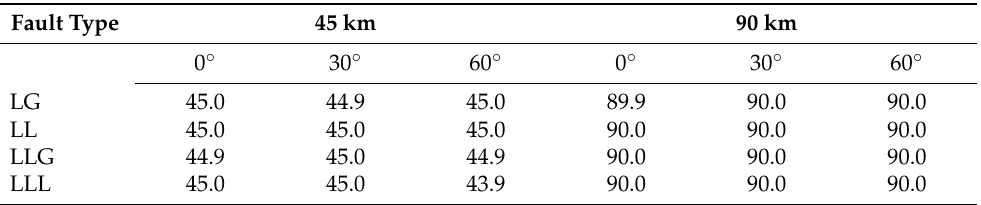
Table 10. Fault estimation at 45 and 90 km with a 10 Ω fault impedance.